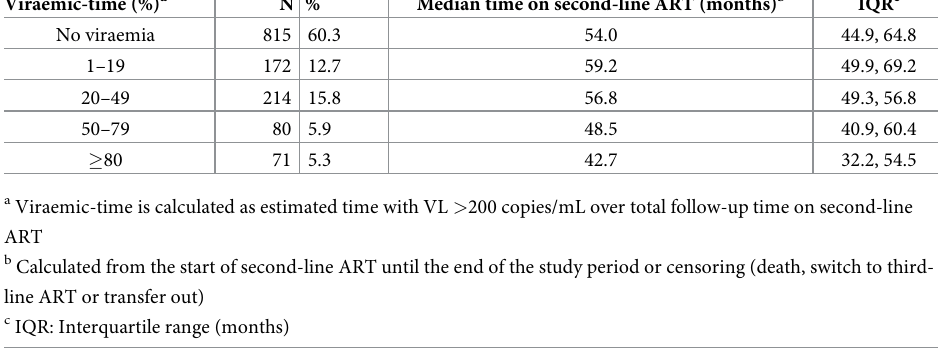
Table 2. Proportion of time with viraemia > 200 copies/mL while on second-line treatment (N = 1,352). Viraemic-time (%) a